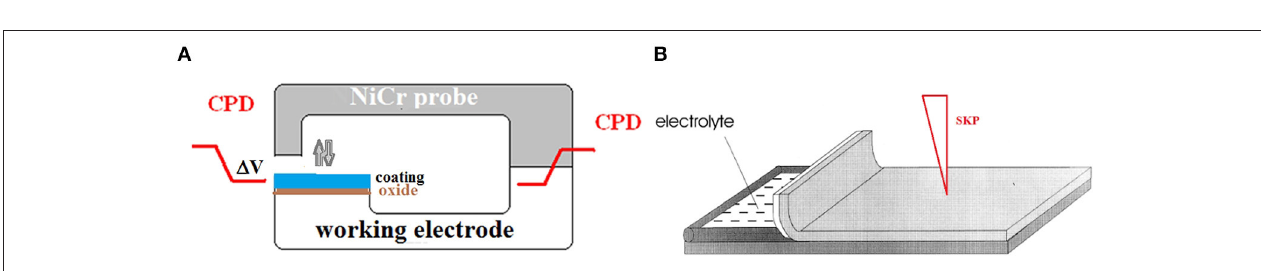
of an electron in a metal (Equation 5; Hölzl and Schulte, 1979; Trasatti and Parsons,